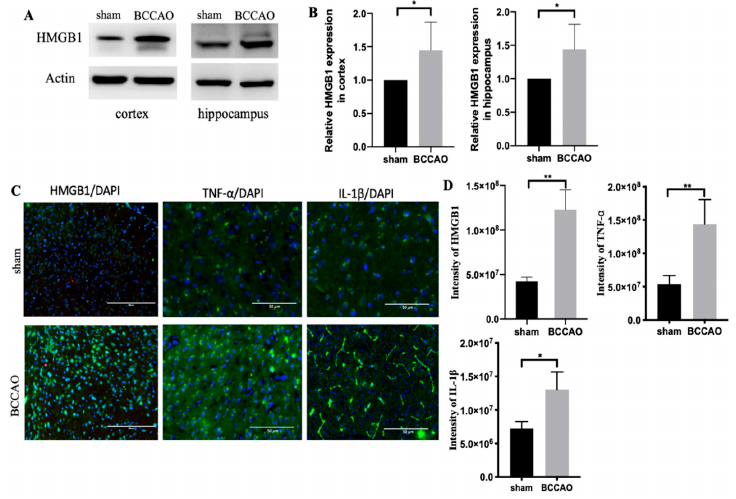
Figure 3. Increased high-mobility group box protein 1 (HMGB1) and its proinflammatory cytokines (tumor necrosis factor-alpha [TNF- α ] and interleukin [IL]-1 β ) in the cortex and hippocampus at 3 months after chronic cerebral hypoperfusion (CCH). ( A ) Western blot results of HMGB1 in the cortex and hippocampus. ( B ) Quantification results of HMGB1 relative protein in the cortex and hippocampus. ( C ) Immunostaining of HMGB1, TNF- α , and IL-1 β in the cortex. ( D ) Quantification data of immunostaining image. n = 6 for each group. Data are presented as the mean + standard deviation; * p < 0.05; ** p < 0.01 with unpaired t-test; scale bar = 50 µ